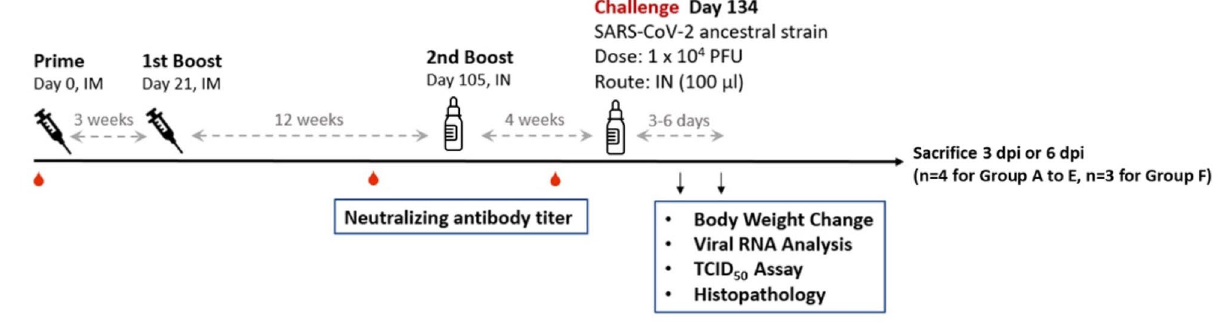
Figure 1. Design of the hamster challenge study. Hamsters (N = 8 for group A–E and N = 6 for group F) were immunized once (groups B and D), or twice (groups A, C and E) at three weeks apart for intramuscular immunization. Groups A, B and E were boosted by single intranasal immunization at the end of 12 weeks post last IM immunization. Serum samples were taken for immunogenicity assays at 91 and 126 days after the first immunization. At 134 days after the first immunization, hamsters were challenged with 10 4 PFU of SARS- CoV-2 ancestral strain. The animals were euthanized on the third or sixth day after infection for necropsy and tissue sampling to determine viral load. Body weight of individual hamster was tracked daily up to the time of